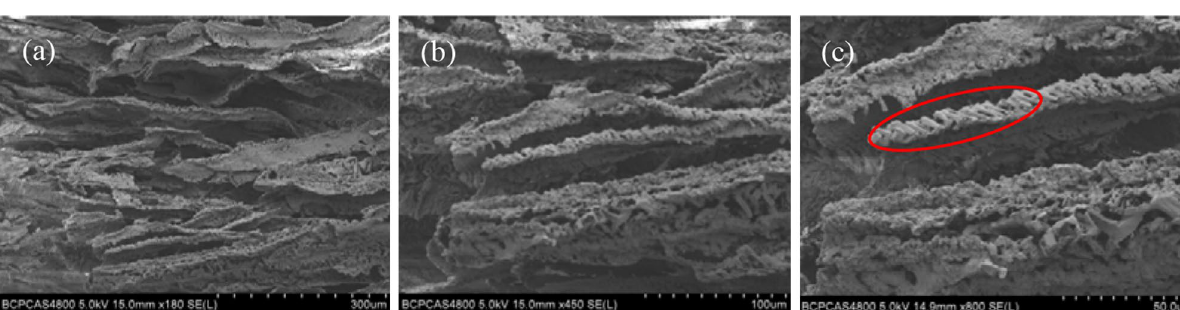
Figure 2. SEM images of cross sections of laminated AP composite at different